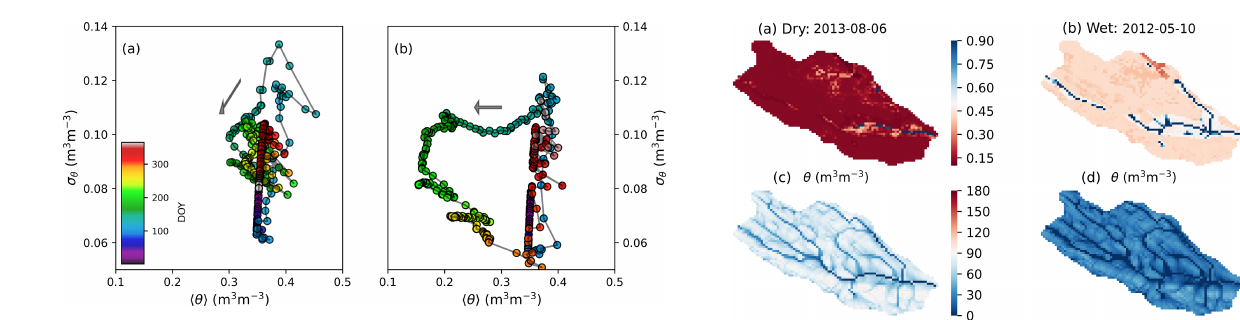
Figure 8. The relationship between catchment daily mean soil moisture (cid:104) θ (cid:105) and its spatial standard deviation σ θ over the course a wet (2012) and dry (2013) year at C3 Porkkavaara. The color scale shows day of year (doy).